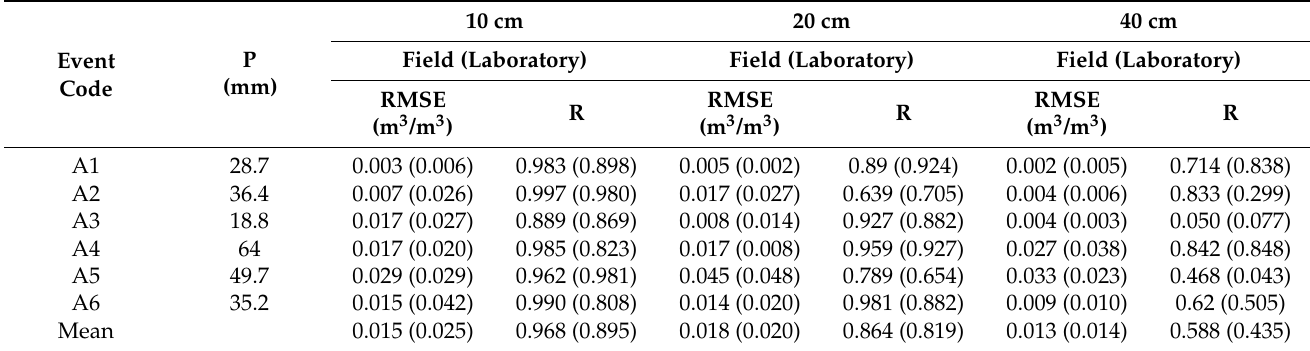
Table 4. Fitting index of soil water dynamic